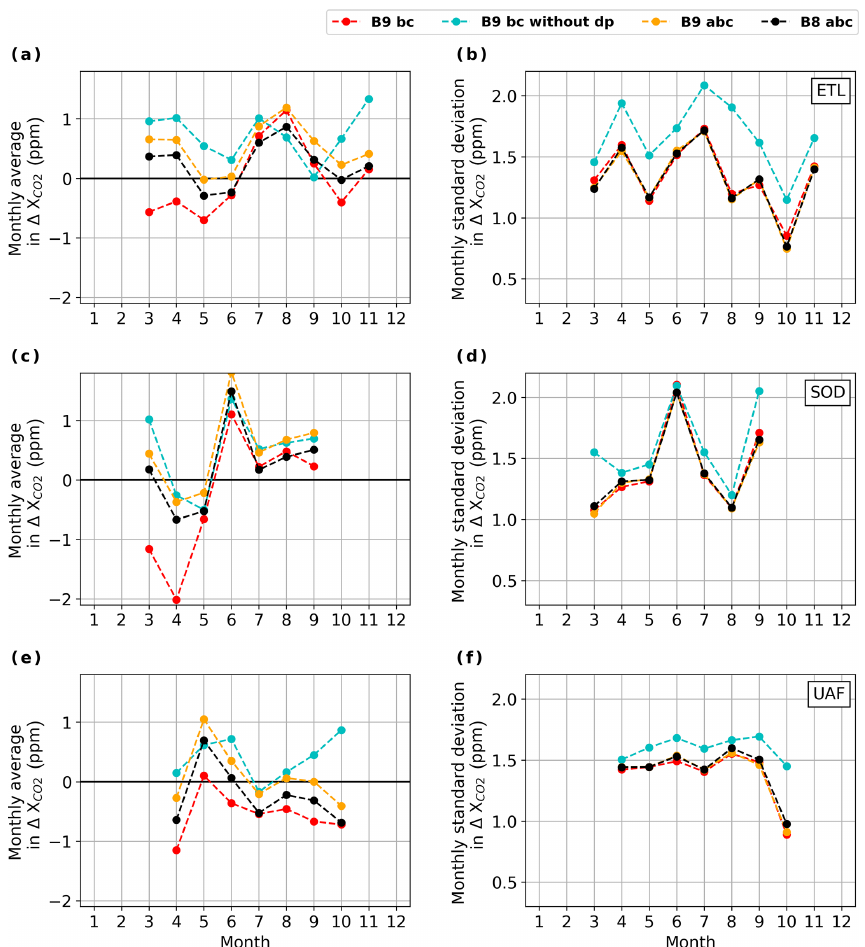
Figure 15. Monthly average bias (a, c, and e) and standard deviation in biases (b, d, and f) of coincident OCO-2 soundings at each of the three boreal forest sites with boreal QC filtering and given each of the following bias correction modifications: the standard B9 bc (Eq. 4), the B9 bc without the dpfrac term, B9 abc with a term for temperature at 700hPa (T700; Eq. 6), and B8 bc with a term for T700 (Eq.